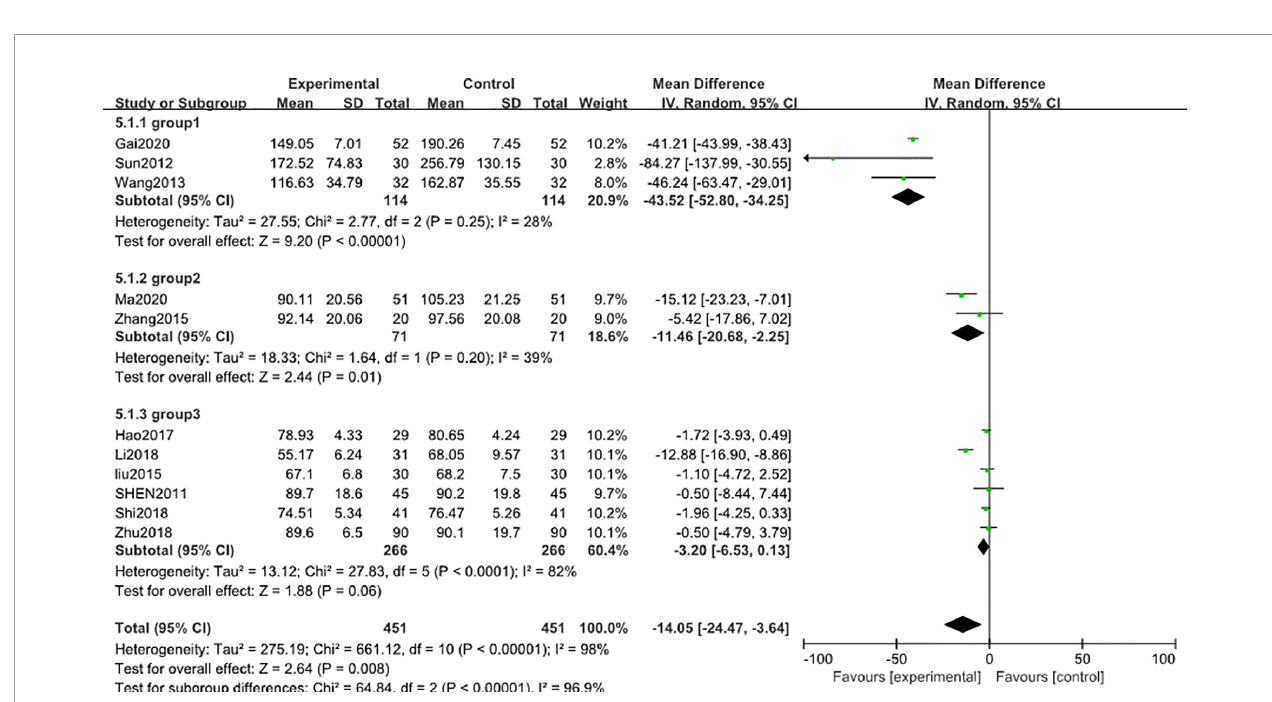
FIGURE 4 | Blood creatinine level after 3 months: comparison of treatment combined with TG against basic treatment.